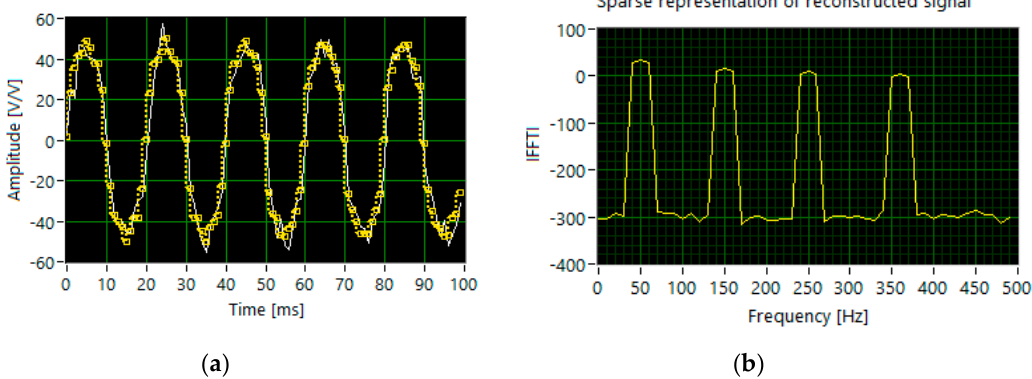
Figure 10. The results of simulation for the input signal (set 2) with the additive noise: ( a ) the segments of time waveforms of the original (white line) and reconstructed signal (dotted yellow line); ( b ) DFT components of the reconstructed signal. The number of measurements is equal to 400. Sensors 2020 , 20 , x FOR PEER REVIEW